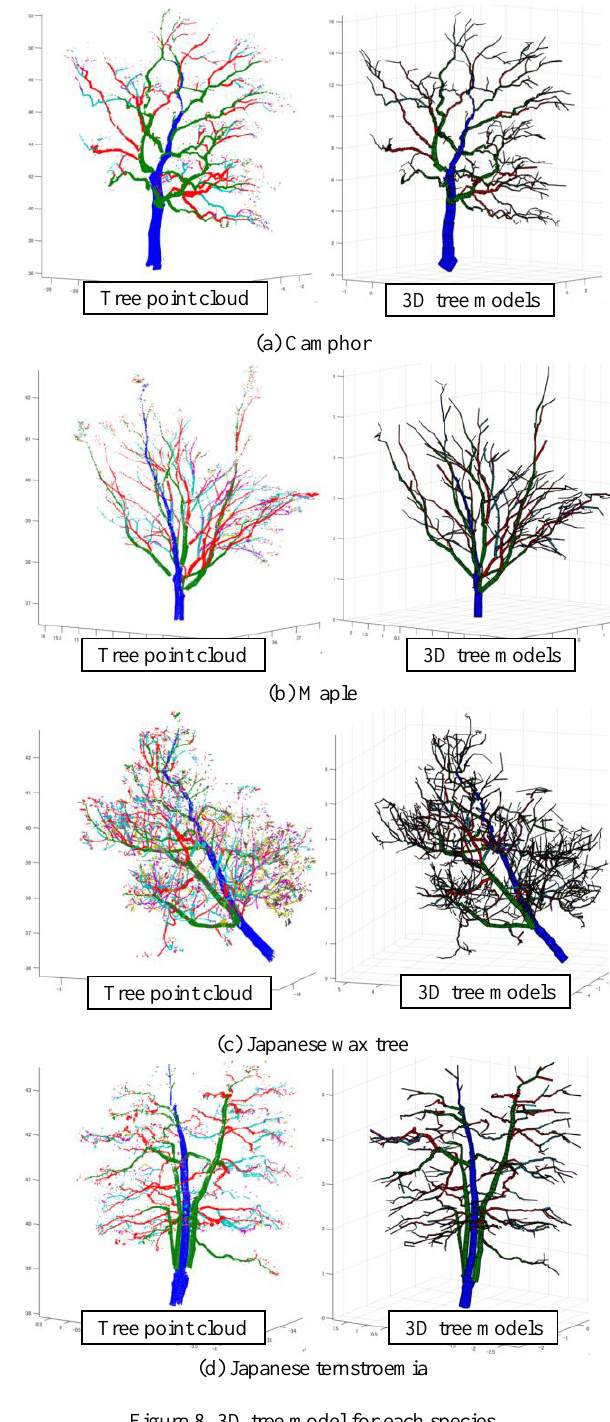
Figure 8. 3D tree model for each